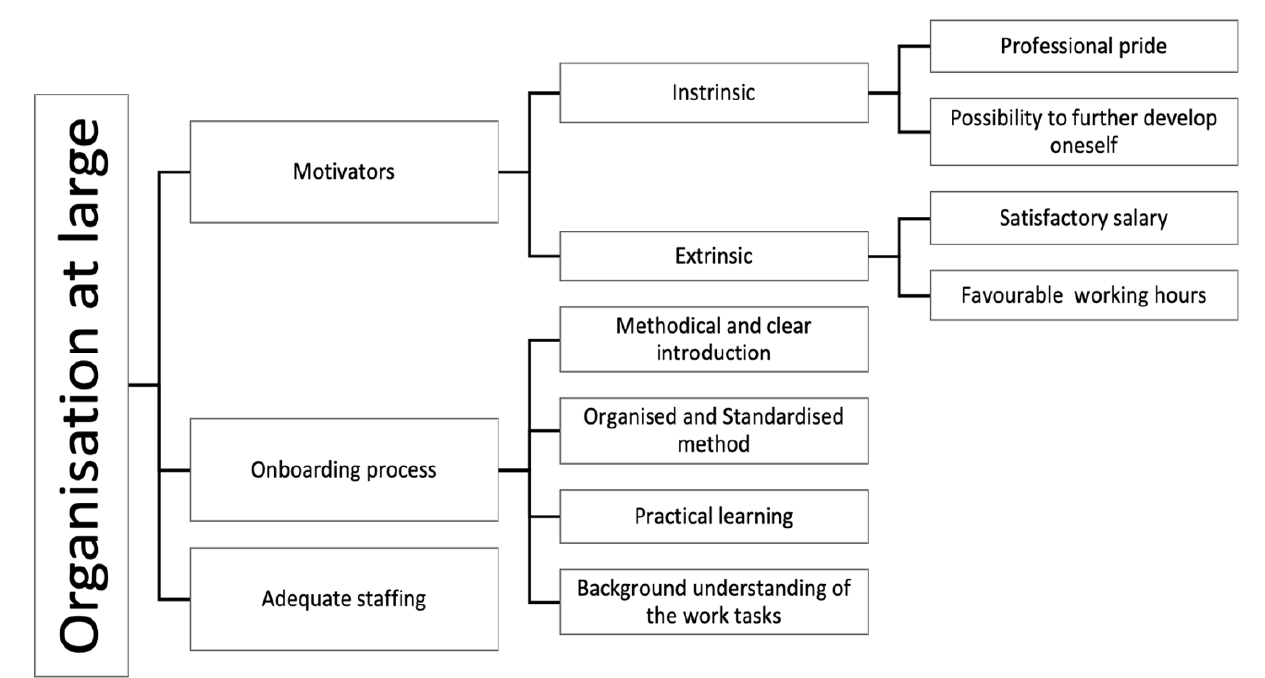
Figure 5. Resources regarding organisation at large.